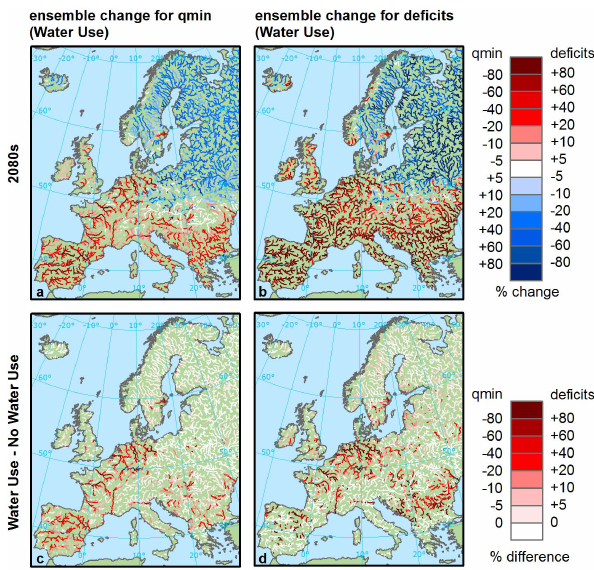
Fig. 9. Ensemble-average change in 20yr return level minimum flow and deficit volumes due to climate change and water consump- tion between the 2080s and the control period (top row) and cor- responding differences with ensemble-average changes driven only by climatic drivers (bottom